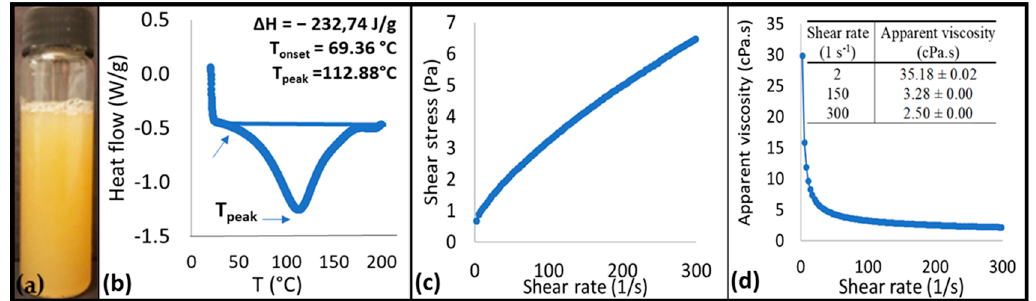
Figure 2. Appearance of CA ( a ); differential scanning calorimetry (DSC) thermogram ( b ); flow curve plotted as shear stress versus shear rate ( c ); and apparent viscosity versus shear rate ( d ) of CA.